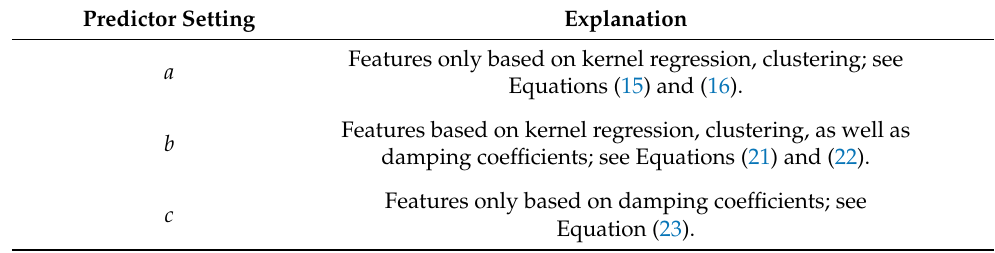
Table 1. Overview of predictor settings used as input for model types listed in Table 2. Predictor Setting Explanation